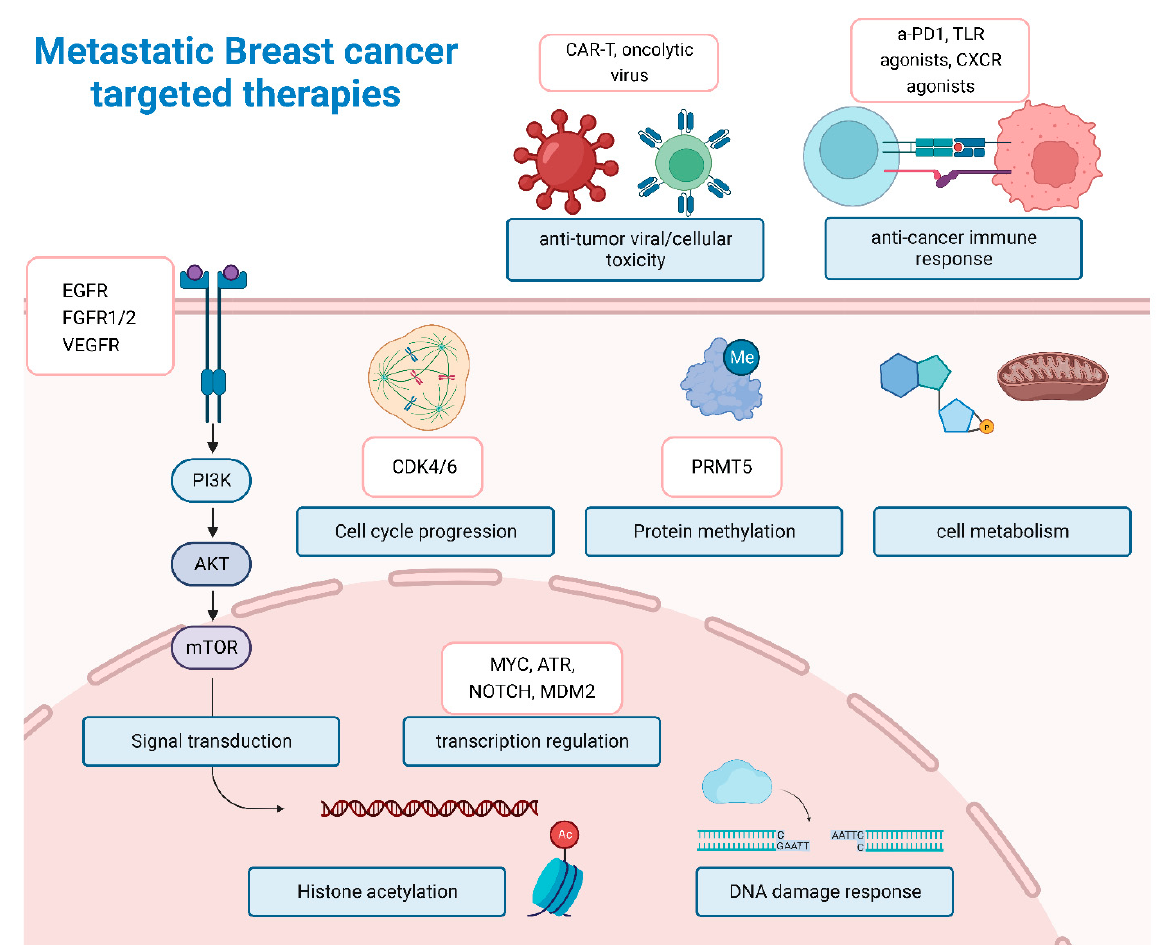
Figure 6. Overview of molecular targets of drugs under current clinical trials for BC. Drugs, phar- maceutical combinations and their targeted molecular pathways currently tested in clinical trials. Details on the clinical trials and abbreviation can be found in Table 3 and the corresponding section.